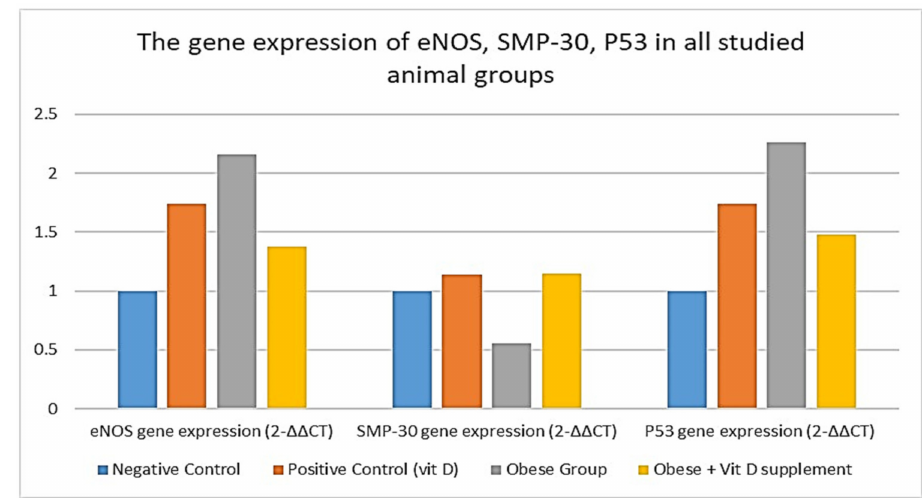
Figure 1. The gene expression of eNOS, SMP-30, and P53 in all studied animal groups. Correlations of serum level of 25(OH)D 3 and SMP-30 with all anthropometric and measured parameters are presented in Tables 3 and 4. There is a significant correlation in all anthropometric parameters with serum 25(OH)D 3 level, except for height. Serum 25(OH)D 3 has a significant negative correlation between weight and BMI. Among the four studied rats’ groups, there is no correlation found between serum 25(OH)D 3 level and other parameters. Serum 25(OH)D 3 level shows a negative correlation with insulin, CK-MB, CK, LDL-C, TG, AST, ALT, cholesterol, glucose, eNOS, and hs-cTnt. However, it has a positive correlation with HDL-C. Table 3. Correlation of hydroxycholecalciferol (nmol/L) level with anthropometric and biochemical parameters. All the Studied